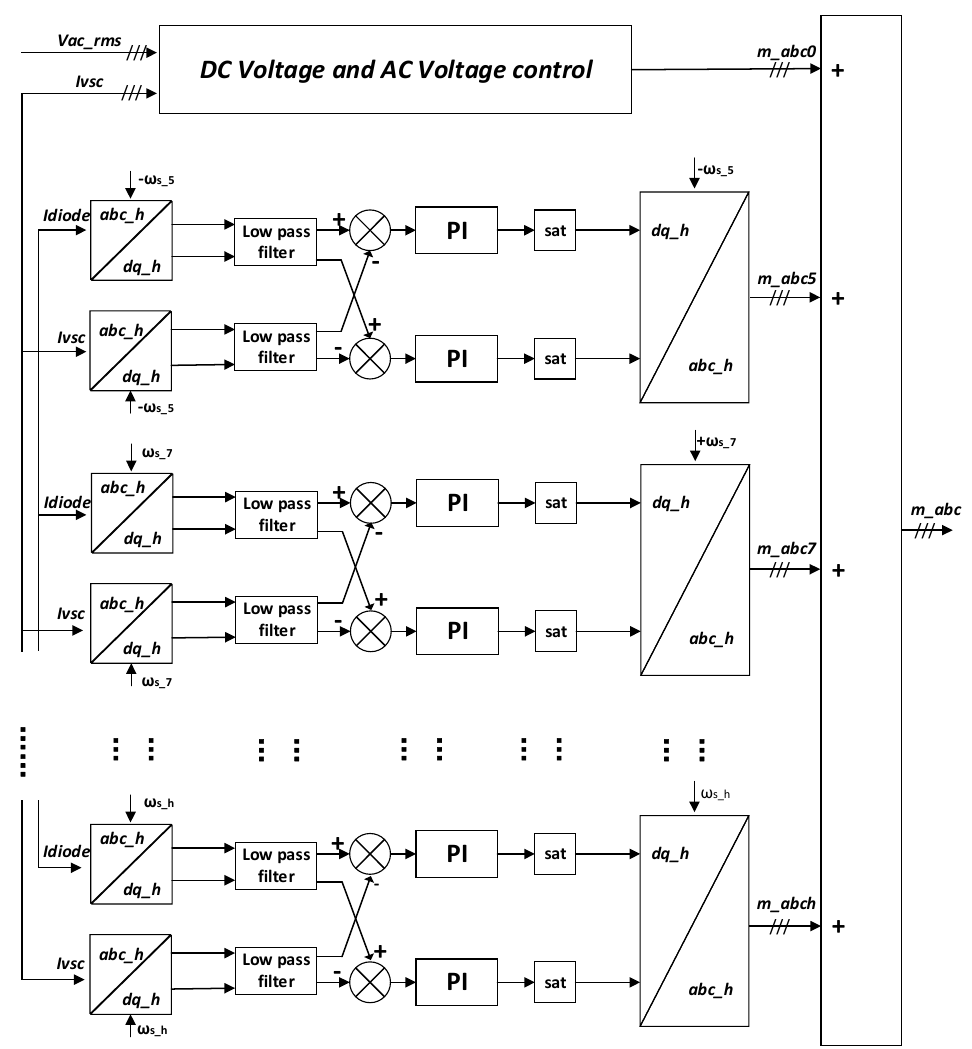
Figure 5. Synchronous reference frame (SRF)-based controller.